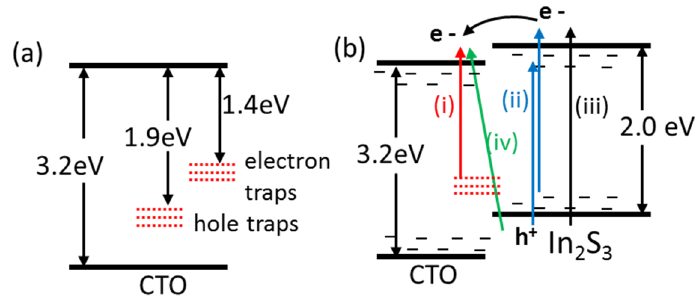
Figure 4. The band diagram of ( a ) bare TiO 2 and CTO layers; and ( b ) CTO/In 2 S 3 double layer.